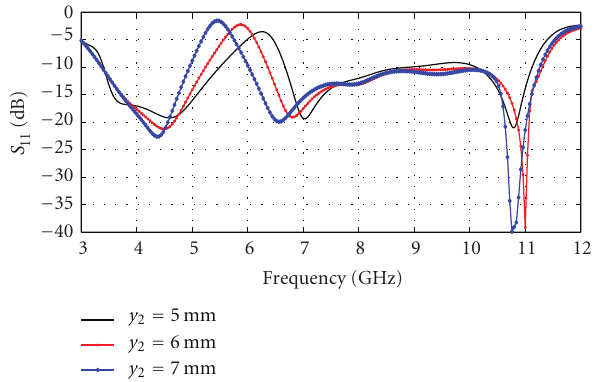
Figure 10: Simulated S 11 (dB) for values of y 2 versus frequency (GHz).